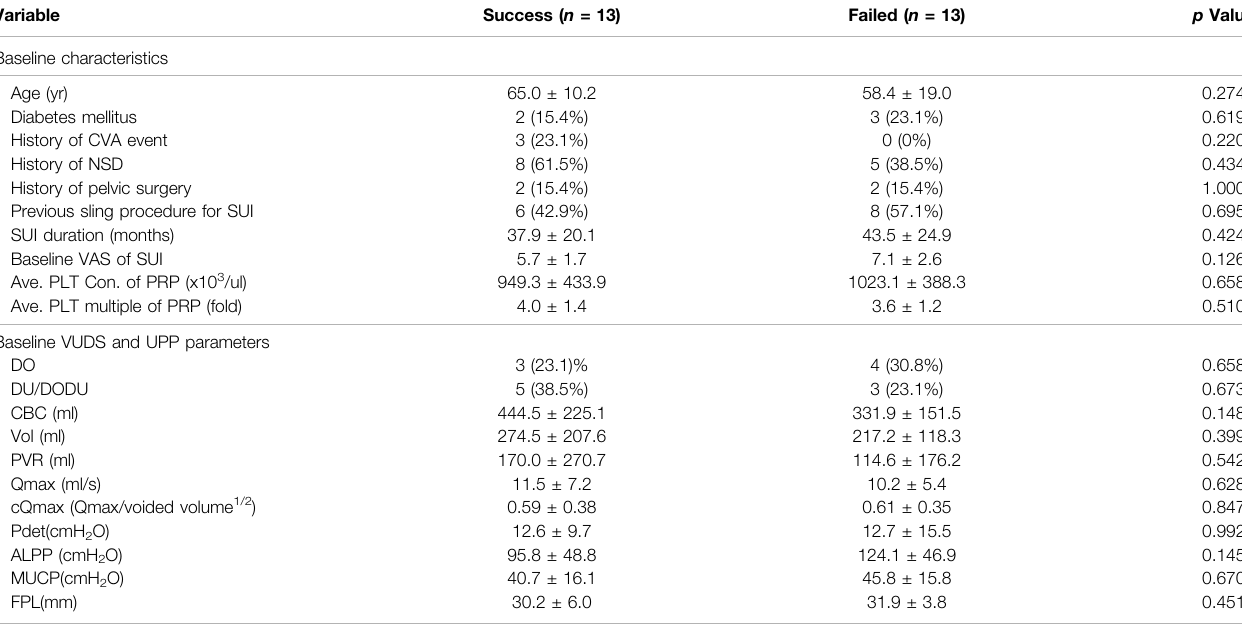
TABLE 3 | Comparison of the baseline demographics and urodynamic parameters between patients with successful and failed treatment